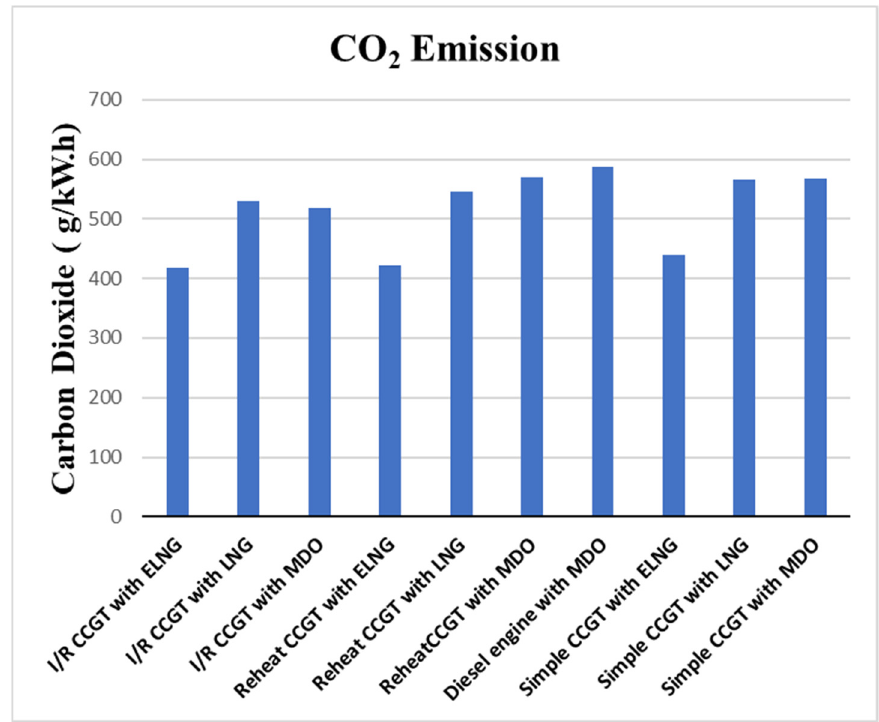
Figure 15. CO 2 emissions from all propulsion systems.